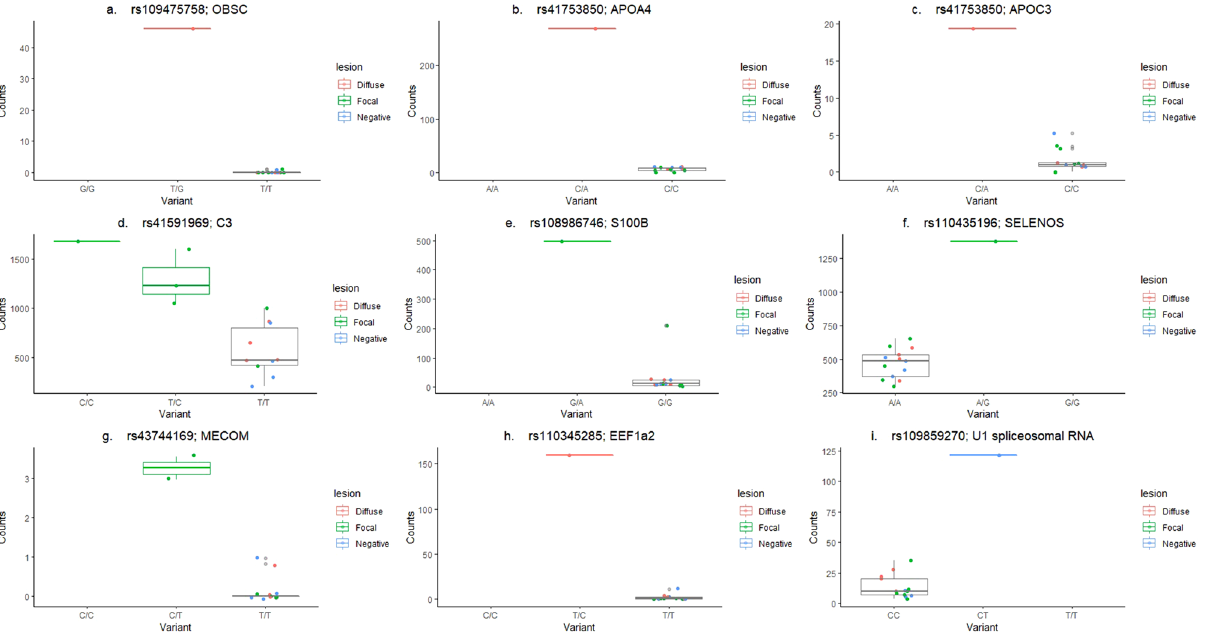
Figure 3. Boxplots for nine significant cis -eQTLs associations with gene expression. The rs109475758 ( a ), rs41753850 ( b , c ), rs41591969 ( d ), rs108986746 ( e ), rs110435196 ( f ), rs43744169 ( g ), rs110345285 ( h ) and rs109859270 ( i ) were associated with the OBSC, APOA4, APOC3, C3, S100B, SELENOS , MECOM , eEF1A2 and U1 spliceosomal RNA expression, respectively. Gene variants are presented on the horizontal axis and gene expression levels, normalized gene counts, on the vertical axes. Samples were grouped according to the absence of lesions (negative) or the presence of focal/multifocal and diffuse lesions in gut tissues. The median and the upper and lower quartiles of each group are represented by horizontal and vertical lines, respectively. The lowest point is the minimum of the data set and the highest point is the maximum of the data